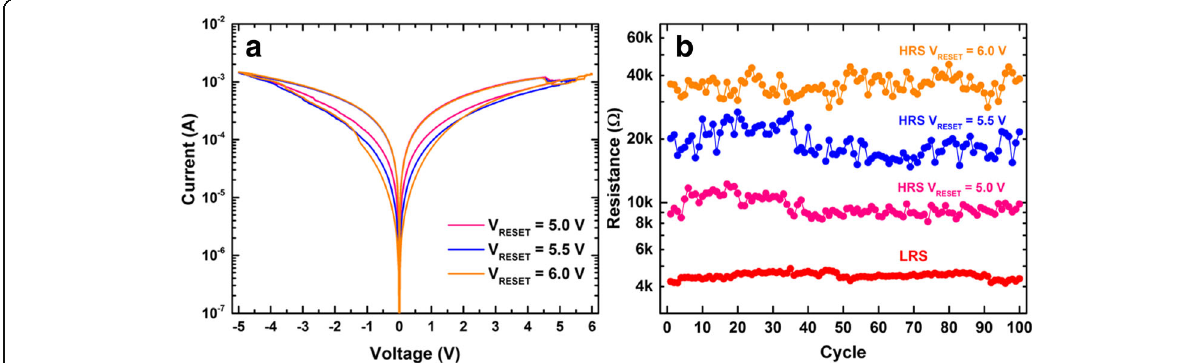
Fig. 8 a I – V characteristics of the interfacial switching for the tri-layer TiN/ZrO 2 /ZrO 2 − x /ZrO 2 /TiN device with varying RESET voltages. b Endurance test of 100 cycles for the interfacial switching with different RESET voltages